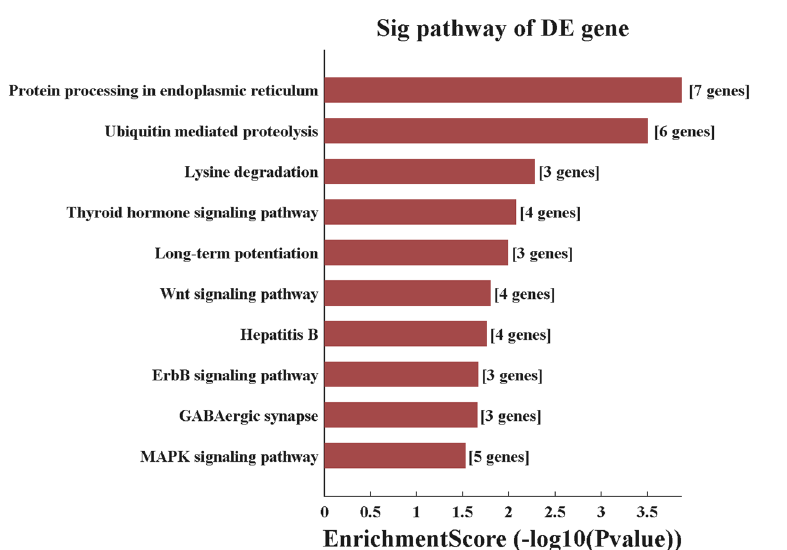
Figure 6. Annotated pathways significantly targeted by